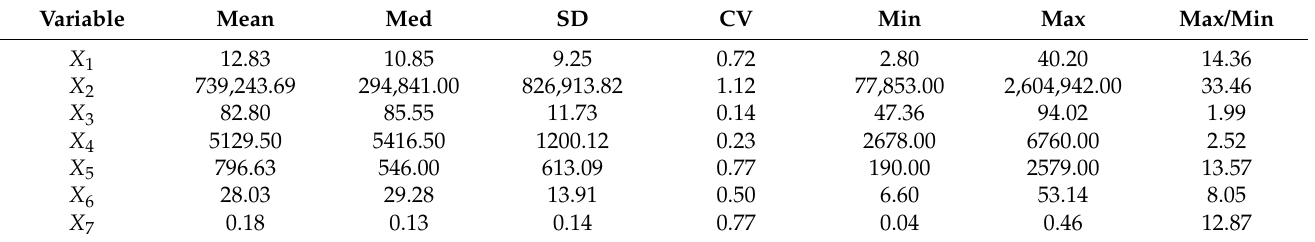
Table 11. Descriptive statistics of diagnostic variables (authors’ calculations based on